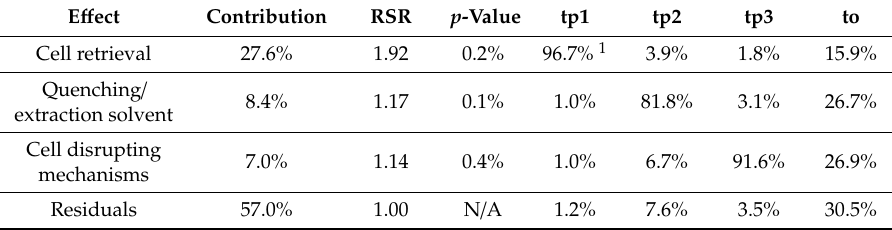
Table 2. Relative variability and block contributions of the AMOPLS model of the data acquired from the investigated biological samples. RSR: residual structure ratio, tp1-3: predictive components, to: orthogonal